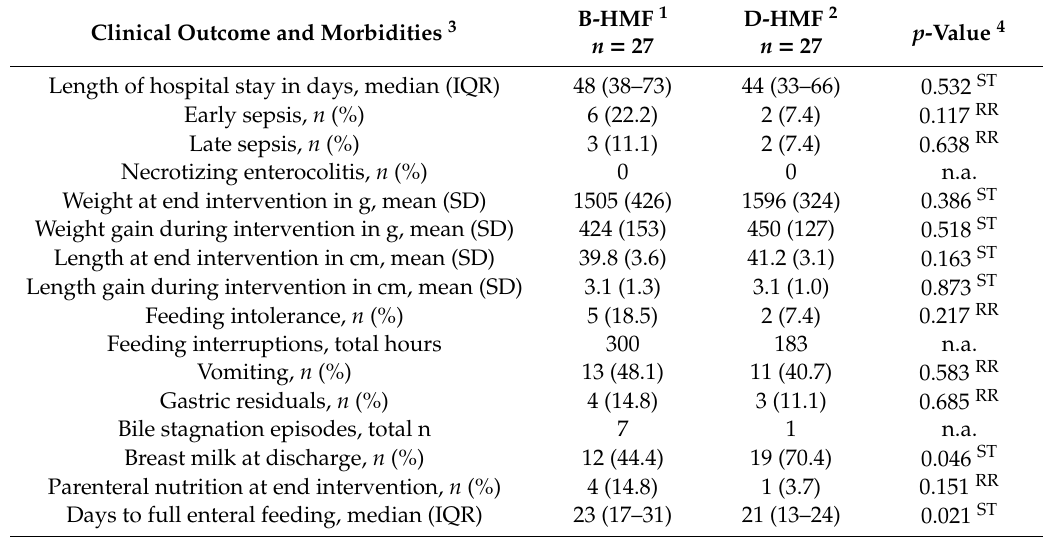
Table 2. Neonatal clinical outcomes and morbidities during the observation period.